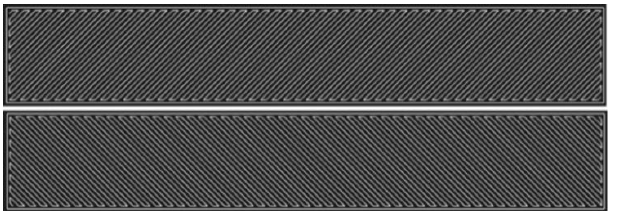
Figure 3. Schematic view of rectilinear matrix arrangement in 3D-printed